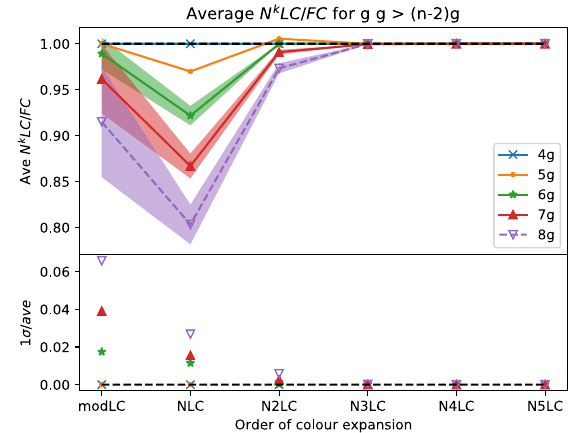
Fig. 3 Accuracy of expansion in colours 1 / N c in the process gg → ( n − 2 ) g compared to the value calculated in standard MG5aMC (FC). modLC is described in Eq. (11) and is a modified LC value, hence it is moreaccuratethanNLCwhichisunmodified.The8glineisdottedsince the accuracy was compared to N5LC rather than FC due to MG5aMC not being able to calculate this process. The top panel shows, for a givencolourorderN k LC,theaverageN k LC/FCvalue,withthestandard deviationintheshadedregion.Thebottompanelshowstherelativeerror